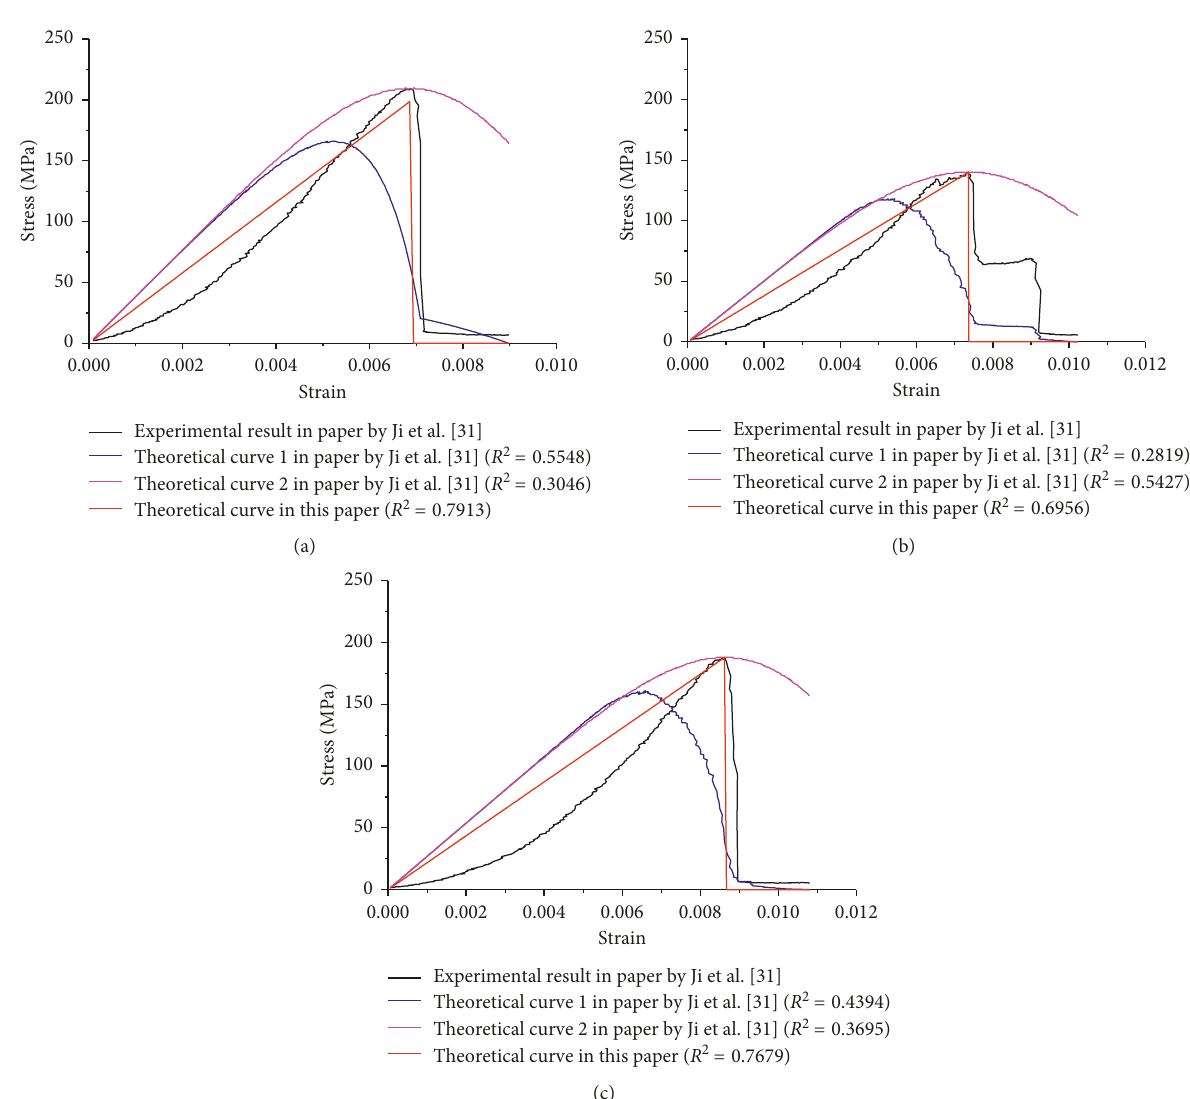
Figure 4: Curves of the theoretical fitting from Ji et al. [31]. (a) Sample no. 1. (b) Sample no. 2. (c) Sample no.